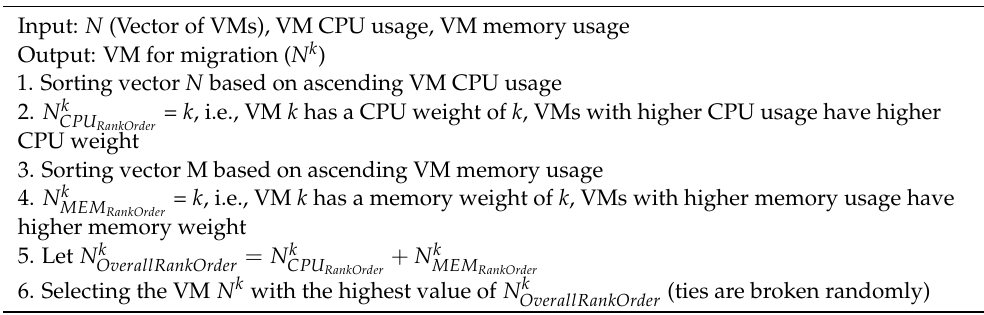
Algorithm 1: Resource-based migration